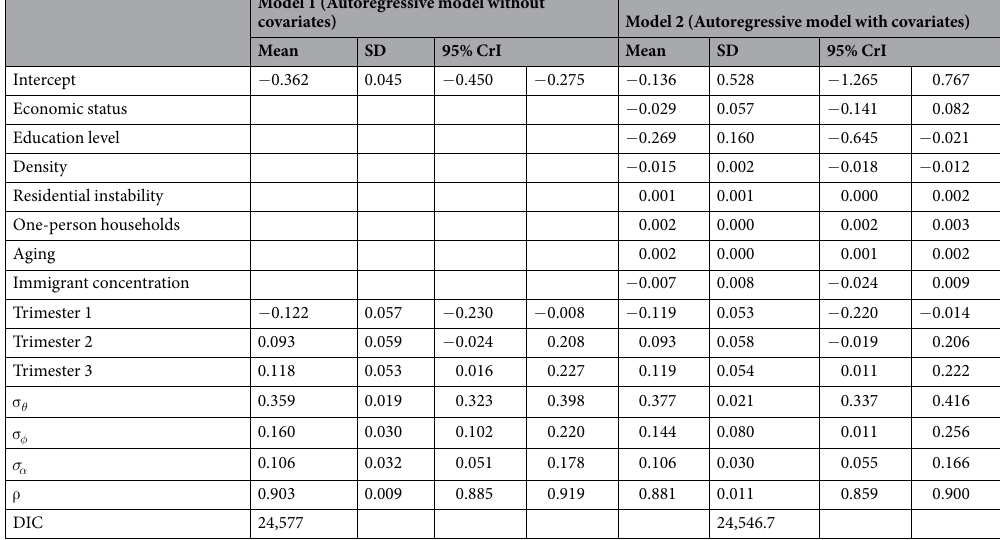
Table 2. Mean, standard deviation and 95% credible interval of the parameters of the autoregressive models. Abbreviations: SD, standard deviation; CrI, credible interval; σ θ , standard deviation spatially unstructured term; σ σ ∝ , standard mean deviation of the risk; ρ temporal φ standard deviation structured term;